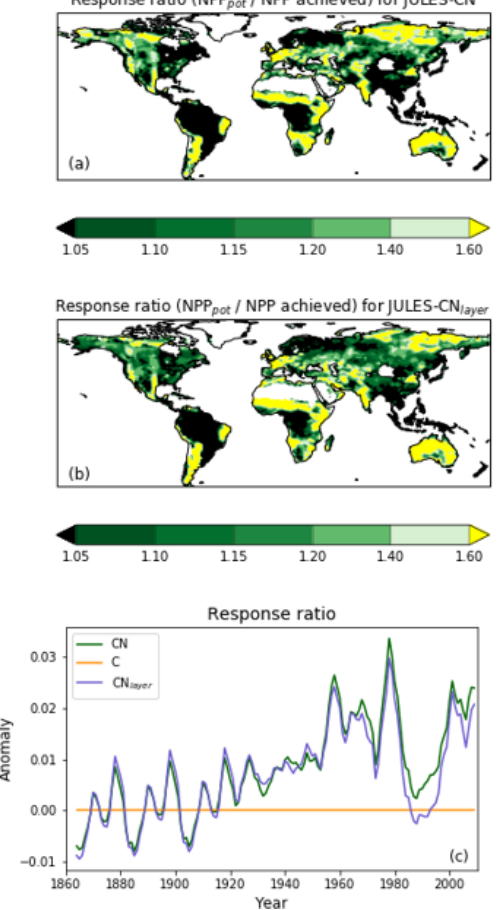
Figure 9. The spatial distribution of the response ratio, defined as the potential amount of carbon that can be allocated to growth and spreading of the vegetation (NPP pot ), as a fraction of the NPP achieved in the natural state for (a) JULES-CN and (b) JULES- CN layer . A value greater than 1 means that the addition of nitrogen will enhance NPP. Any grid cells with an annual NPP of less than 0.016 gCm − 2 are set to missing. This is the spatial distribution of the metric shown in Fig. 10. Panel (c) shows the change in the response ratio over the historical period with respect to the multi- annual mean from the period of 1860–1899.